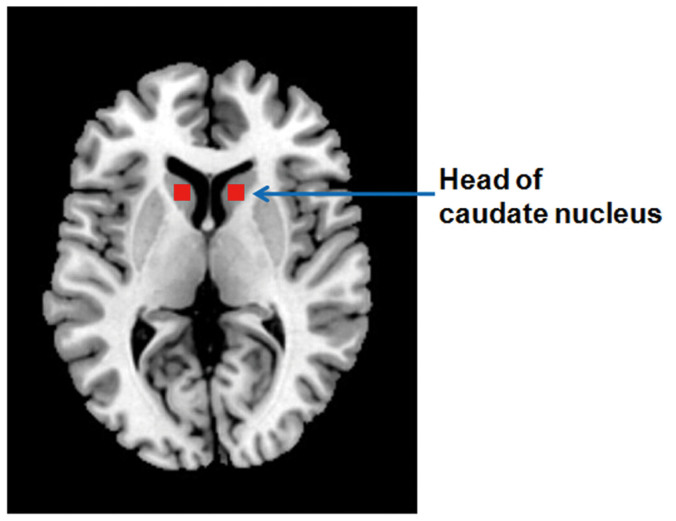
Regions of interest (head of bilateral caudate nucleus) for magnetization transfer ratio analysis.